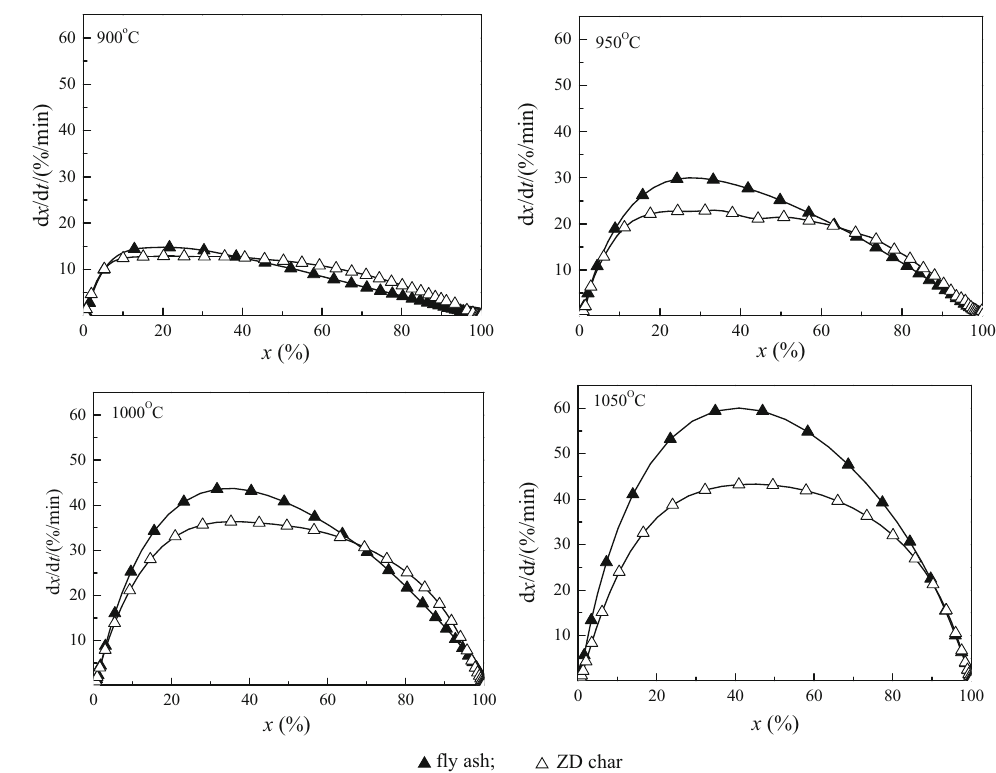
Fig. 7 Gasification reaction rate at different